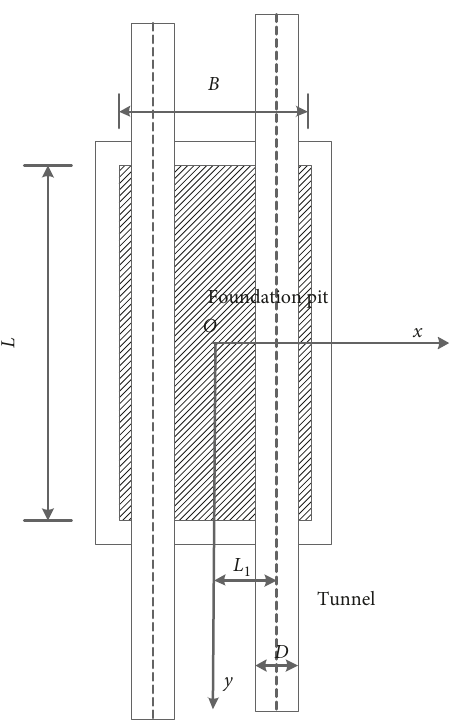
Figure 4: The planform of mechanical model.